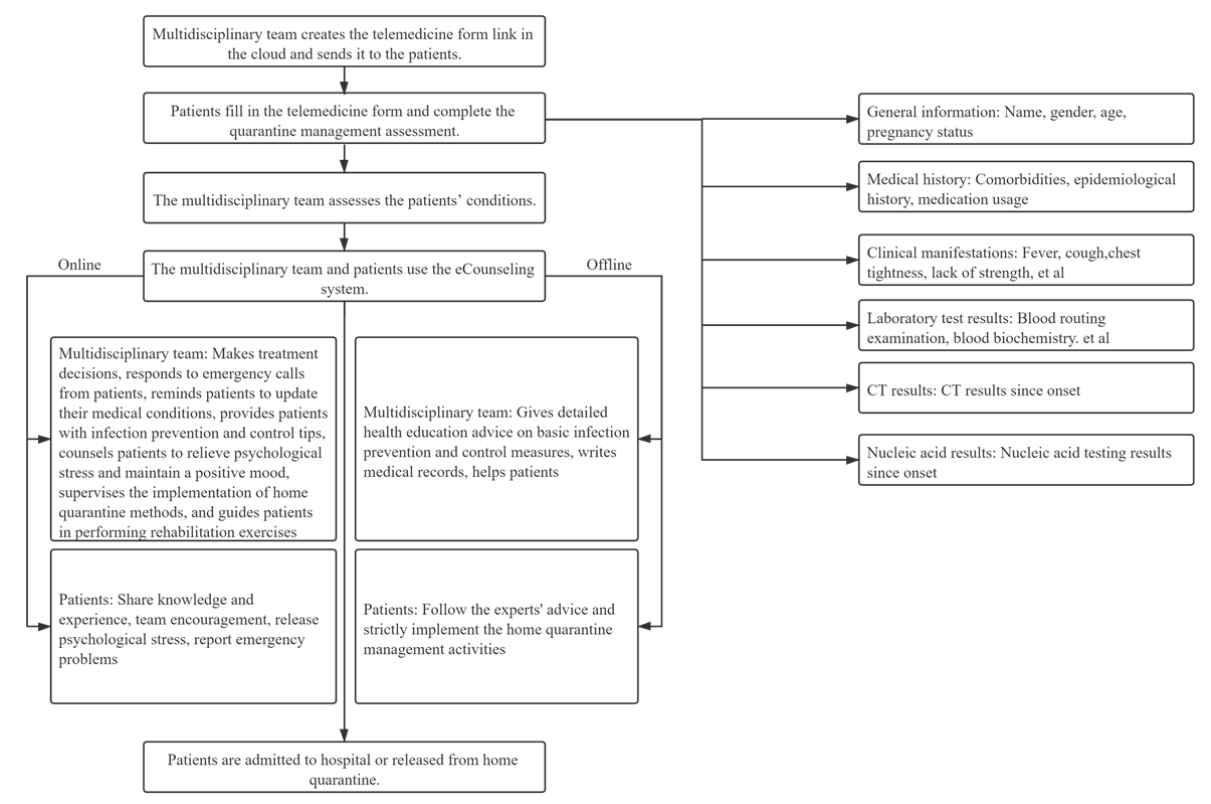
Figure 1. Flowchart of the telemedicine system, including the steps to enroll a patient, conduct self-assessment via the quarantine management assessment, and update conditions using the eCounseling system. CRP: C-reactive protein; CT: computed tomography; eCounseling: electronic counseling; PCT: